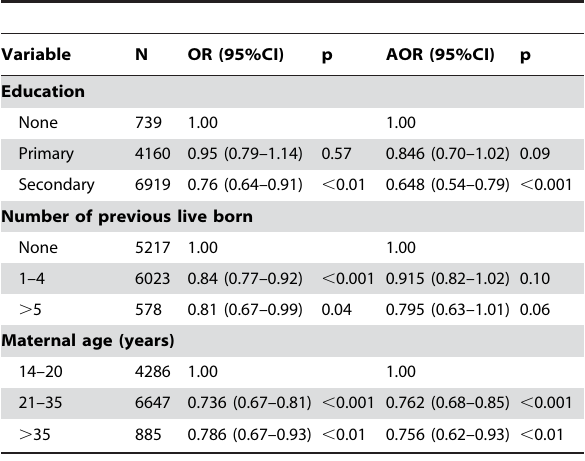
Table 2. Maternal factors associated with agreeing to be tested for HIV